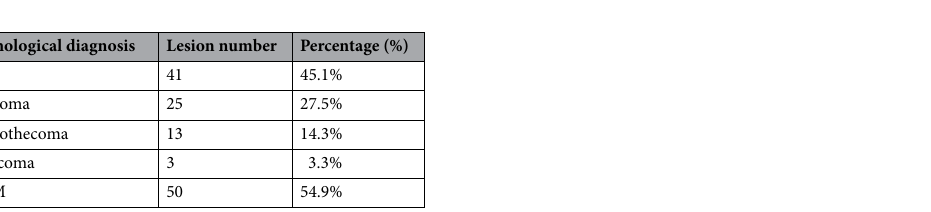
Figure 1. The flow chart of patient selection.